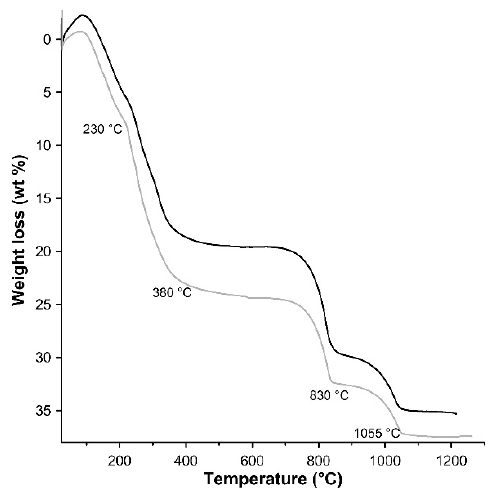
Figure 5. TG patterns of LDH 3CuAl·SO 4 at pH 8 (black line) and pH 10 (grey line).